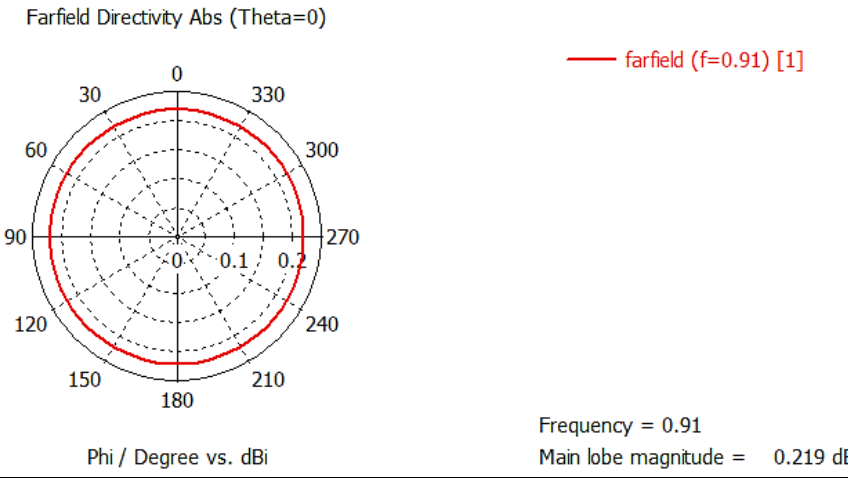
Figure 7. Antenna pattern at first frequency ( 𝑻𝒉𝒆𝒕𝒂 = 𝟎 )